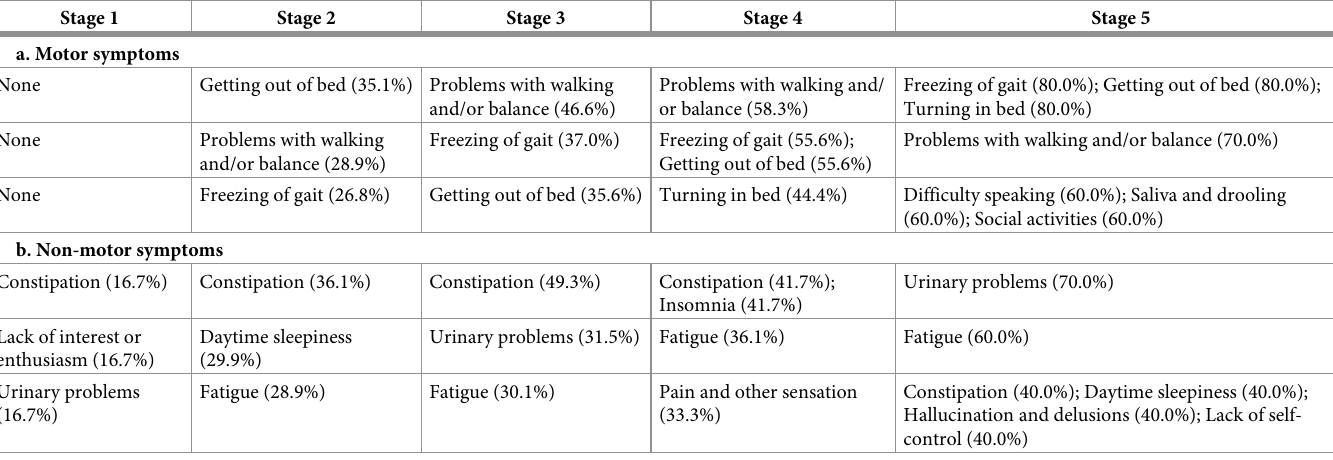
Table 4. Top three symptoms of most commonly concern on (a) motor symptoms and (b) non-motor symptoms according to Hoehn and Yahr stage (n = 222) . Stage